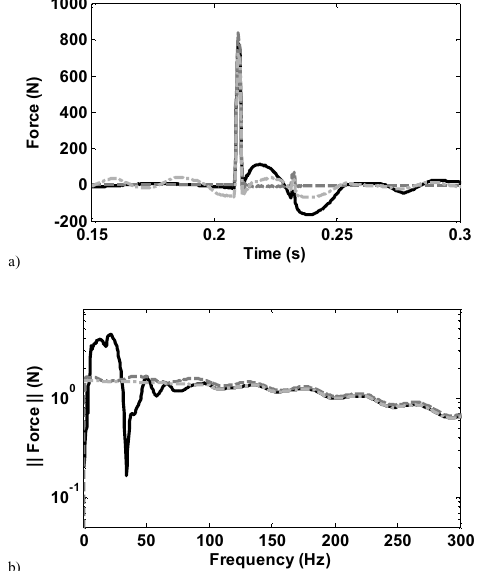
Fig. 27. Comparison of originally estimated force (——), actual force (– – –), and original force with the foam effects minimized (– · – · ) in the a) time and b) frequency domains.